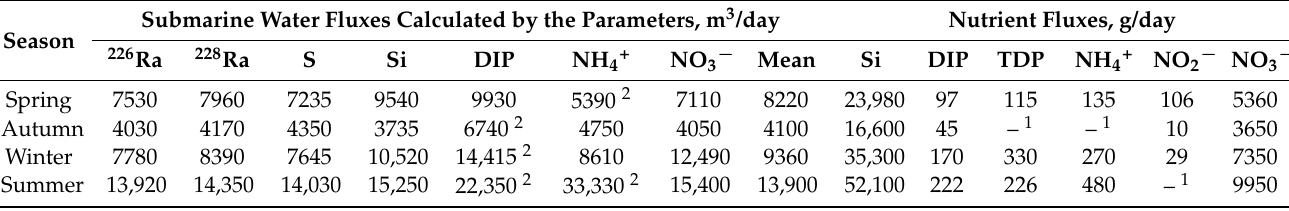
Table 2. Assessment of SGD and nutrient